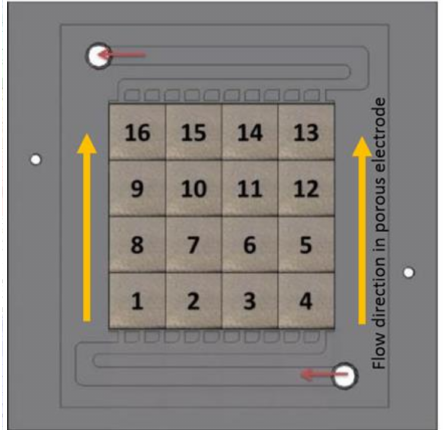
Figure 1. Arrangement of the sixteen segments displaying the direction of electrolyte